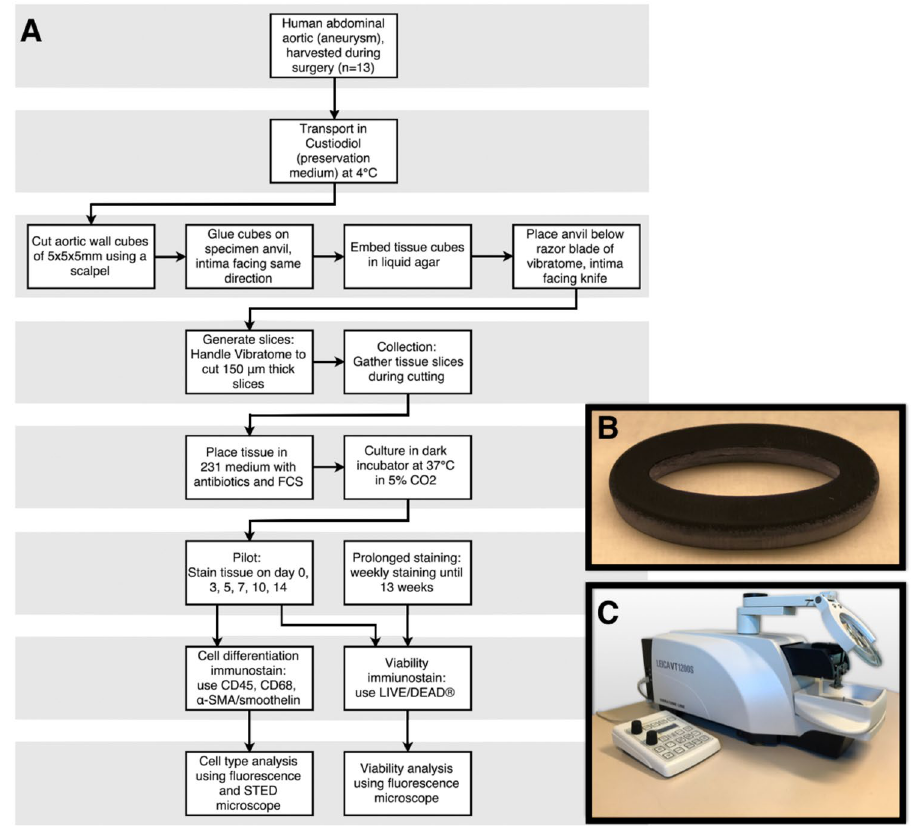
Figure 1. Overview of experimental setup. ( A) Flowchart of protocol: vascular tissue cubes were cut into sections using a vibrating blade microtome (Leica VT1200S). Tissue sections were cultured in supplemented culture medium in 24-well plates in a dark humidified atmosphere at 37 °C in 5% CO 2 . ( B) Photograph of self-designed 3D-printed mould in which tissue cubes are fixed in agarose. ( C ) Photograph of vibratome Leica VT1200S, used for tissue sectioning. α -SMA indicates alpha smooth muscle actin; FCS, fetal calf serum and STED, stimulated emission